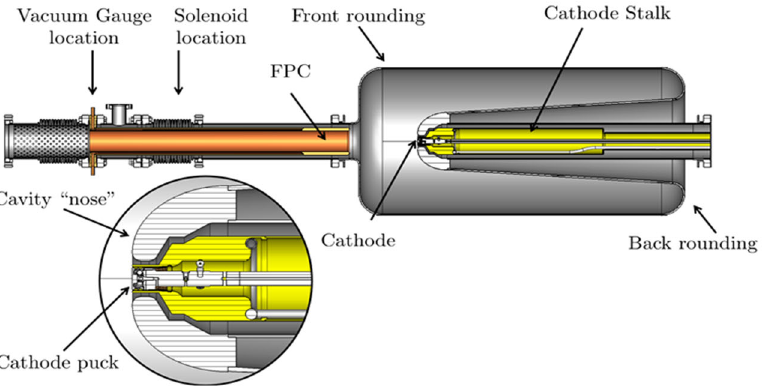
Figure 6. Cross ‐ section of the BNL QWR SRF gun with cathode stalk